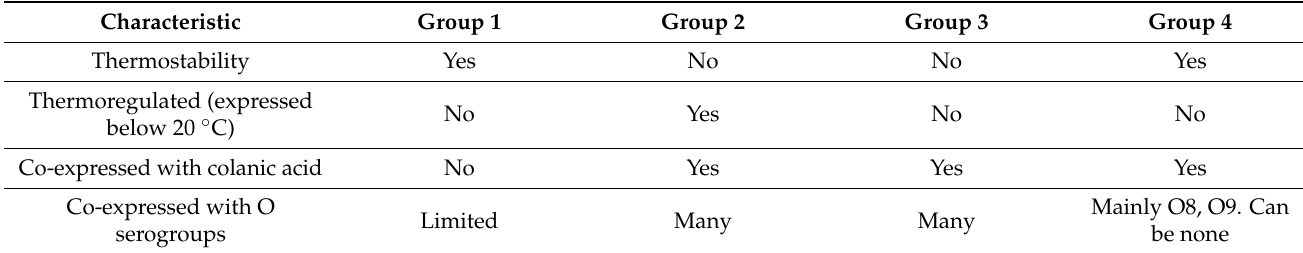
Table 1. Classification of capsules. Classification is based on Whitfield and Roberts 1999 research article [34]. Reprinted with permission from ref [34]. Copyright obtained 2021, John Wiley and